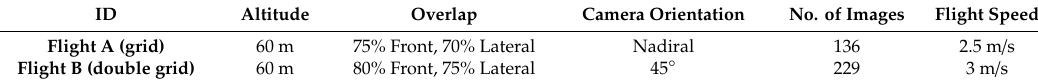
Table 5. Main parameters of the flight plans programmed in the area of Tempio di Diana.